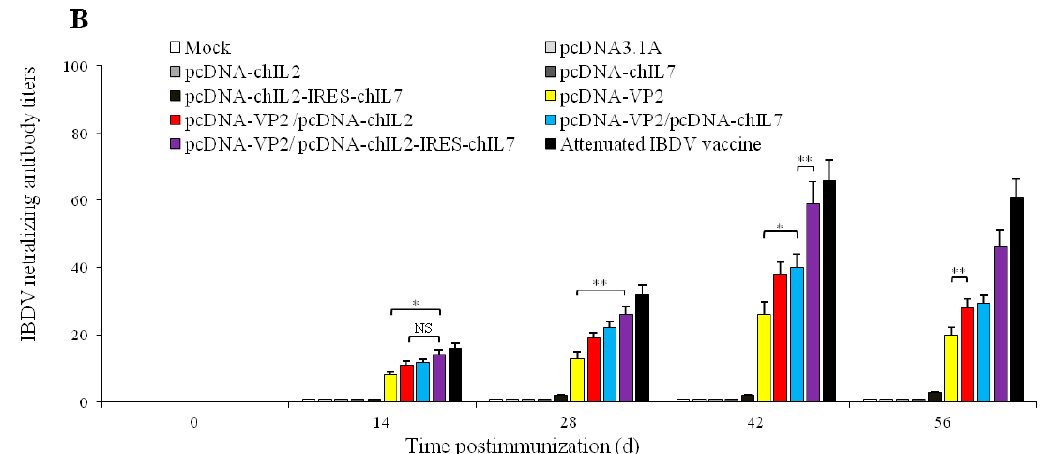
Figure 4. Antibody titers in immunized chicken and viral neutralization test. ( A ) IBDV antibody titers in the chickens of different groups at different time post immunization measured by ELISA. ( B ) IBDV neutralizing antibody titers in the chickens measured by viral neutralization test. Values are expressed as mean ± SD. ** p < 0.01, * p < 0.05, NS, no significance.